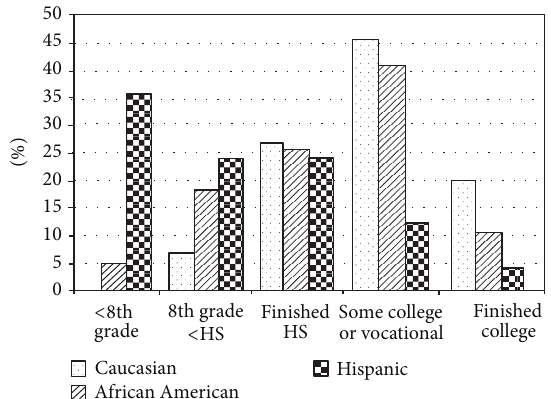
Figure 1: There was a significant difference in educational level between the 3racial/ethnic groups ( 𝑃 = 0.006 ). Group by group comparison: Caucasian versus African American: 𝑃 = 0.7 ; Caucasian versus Hispanic: 𝑃 = 0.04 ; African American versus Hispanic: 𝑃 = 0.01 . HS = High